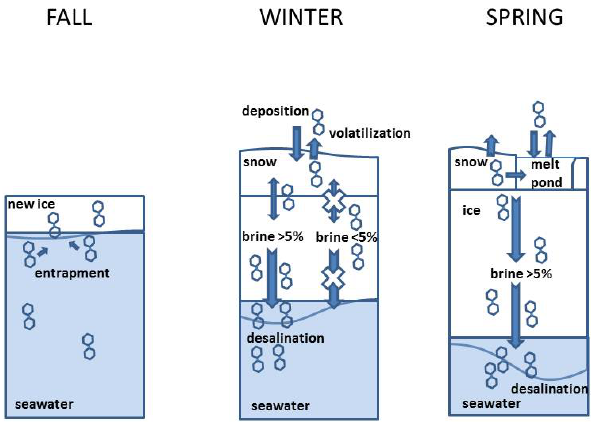
Fig. 4. Sea-ice formation and growth during the winter season and associated behavior of POPs. During sea-ice growth in the fall and winter, chemical contaminants in the seawater become entrapped with brine in the forming ice. Subsequent freezing-out concentrates the brine resulting in the enrichment of contaminants. If the brine fraction of the ice exceeds 5% then desalination may occur with subsequent ejection of the contaminants into the beneath–ice envi- ronment. Upward percolation of brine may also occur into the over- lying snowpack. During winter most of the ice-column exhibits a brine content < 5% resulting in reduced brine movement and the “locking” of contaminants in the ice. During spring, the brine frac- tion increases again due to melt and further desalination may occur into the under-ice seawater. Contaminants deposited in the snow- pack are subject to exchange processes with the atmosphere. Re- maining residues present in the snowpack during spring melt may percolate into the sea-ice or be flushed into meltwater ponds. These dynamic processes concentrate and flush contaminants from sea- sonal, first-year ice, which is the dominant sea-ice in a warming Arctic.